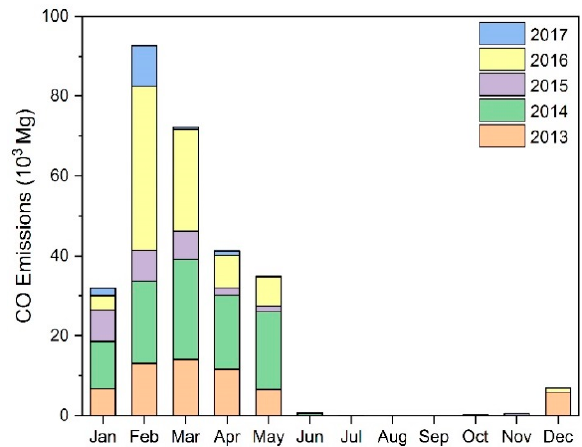
Figure 8. Monthly CO emissions of forest fires from 2013 to 2017 in Yunnan.